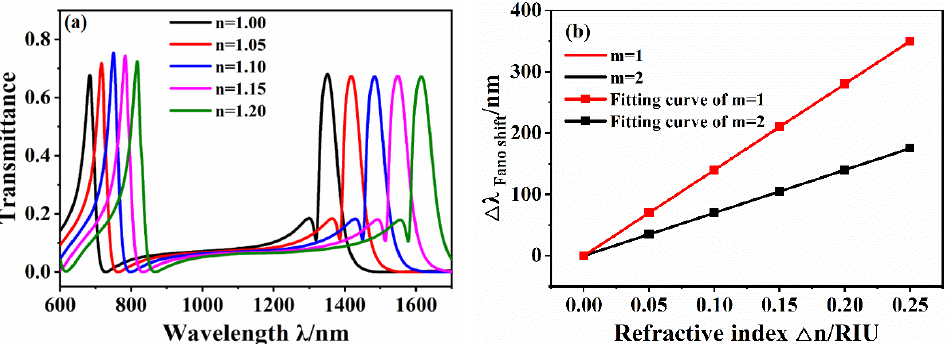
Figure 4. ( a ) Transmission spectrum of waveguide structure under different refractive index n. ( b ) Sensitivity fitting curve.